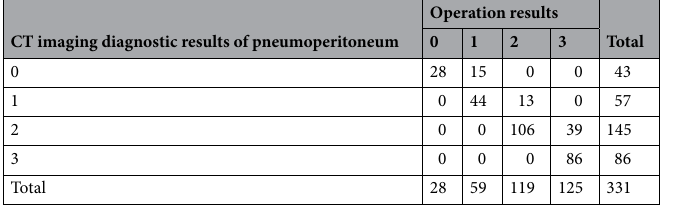
Table 2. Comparison of CT imaging diagnostic results of pneumoperitoneum and operation results.